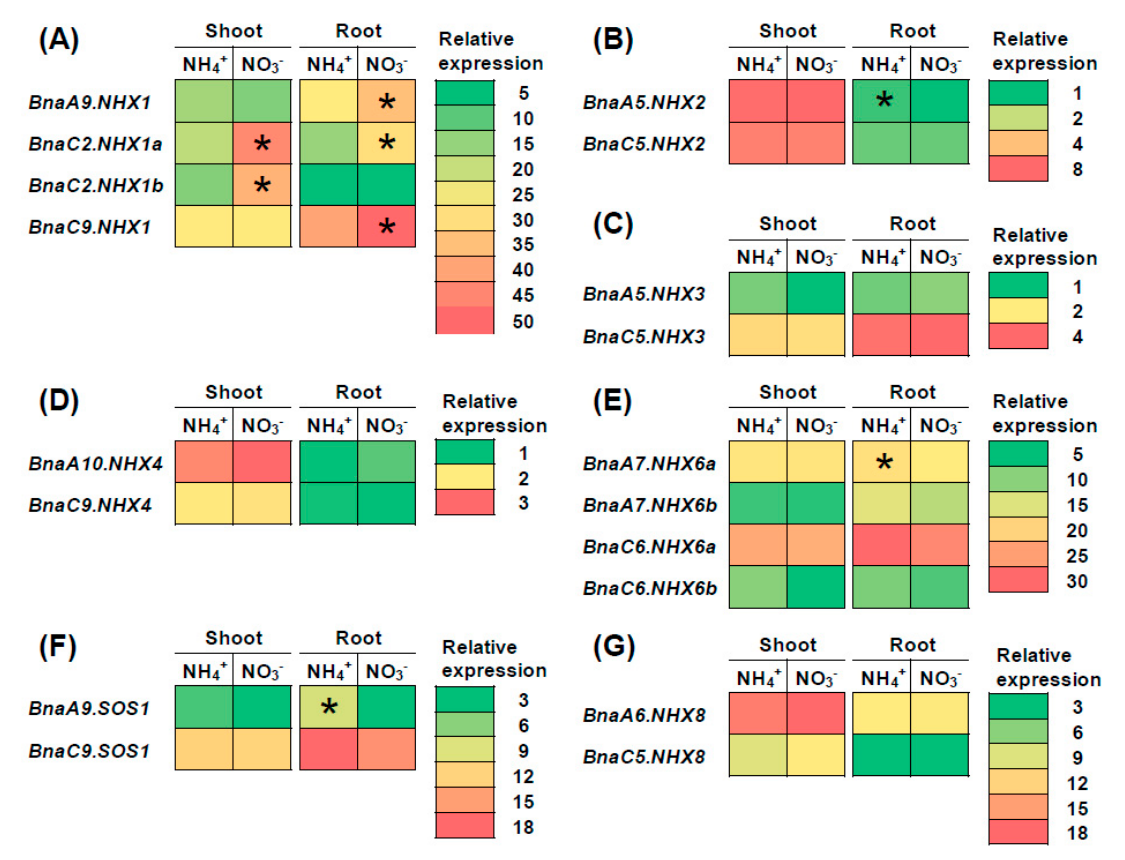
Figure 8. The qRT-PCR-assisted transcriptional characterization of the Na +/ H + antiporters ( NHXs ) in Brassica napus under different forms of nitrogen (N) conditions. Differential expression of BnaNHX1s ( A ), BnaNHX2s ( B ), BnaNHX3s ( C ), BnaNHX4s ( D ), BnaNHX5s ( E ), BnaNHX6s ( F ), BnaNHX7s ( G ), and